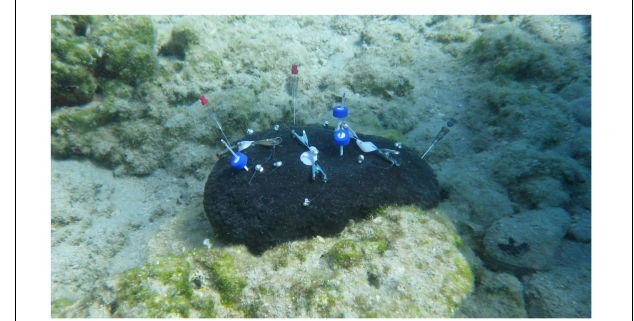
FIGURE 1 | Individual Sarcotragus foetidus during in situ extraction with membrane, blade, and fiber SPME